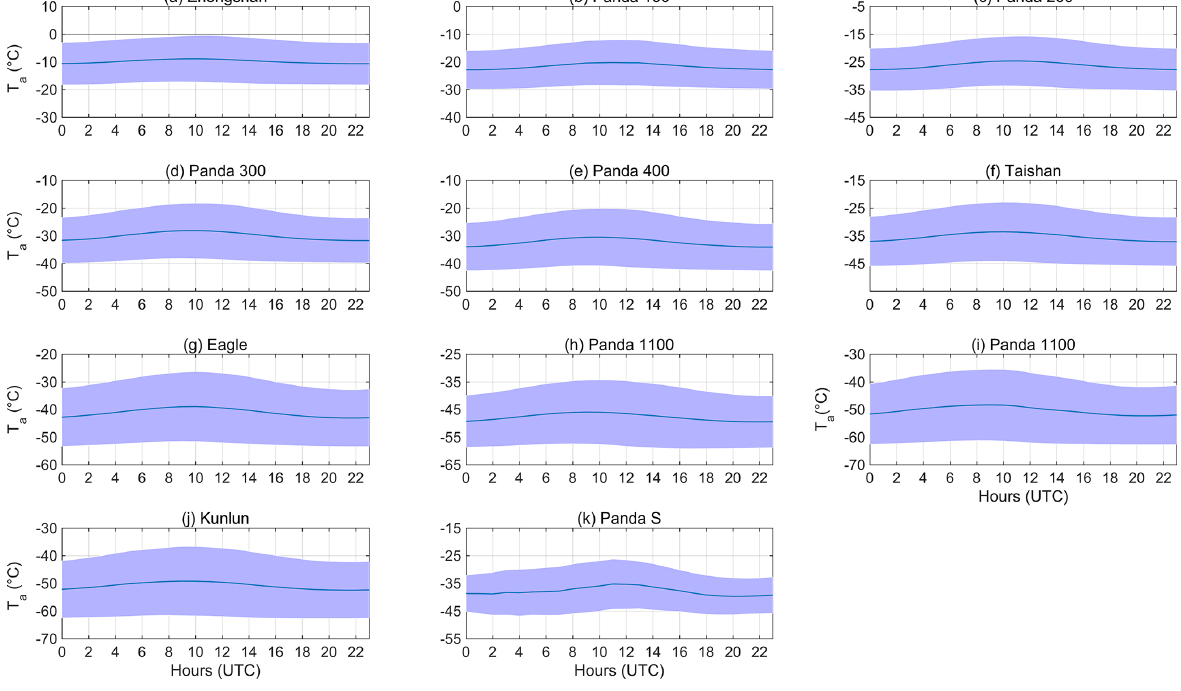
Figure 3. Average diurnal variation in air temperature at AWSs in the PANDA network. The calculation years for these sites are the same as for Fig. 1, except that Zhongshan is calculated during